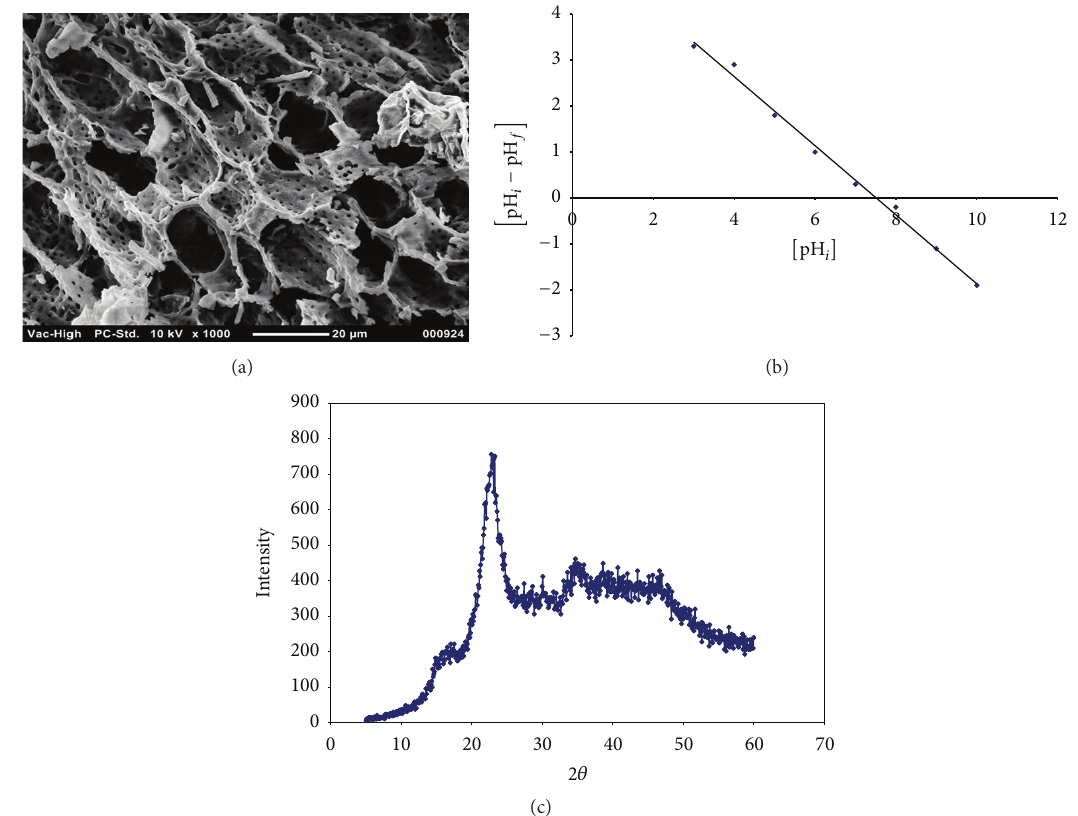
Figure 3: (a) SEM image (magnification: × 1000), (b) pH point of zero charge (pH zpc ) plot, and (c) X-ray diffraction patterns of RSD.